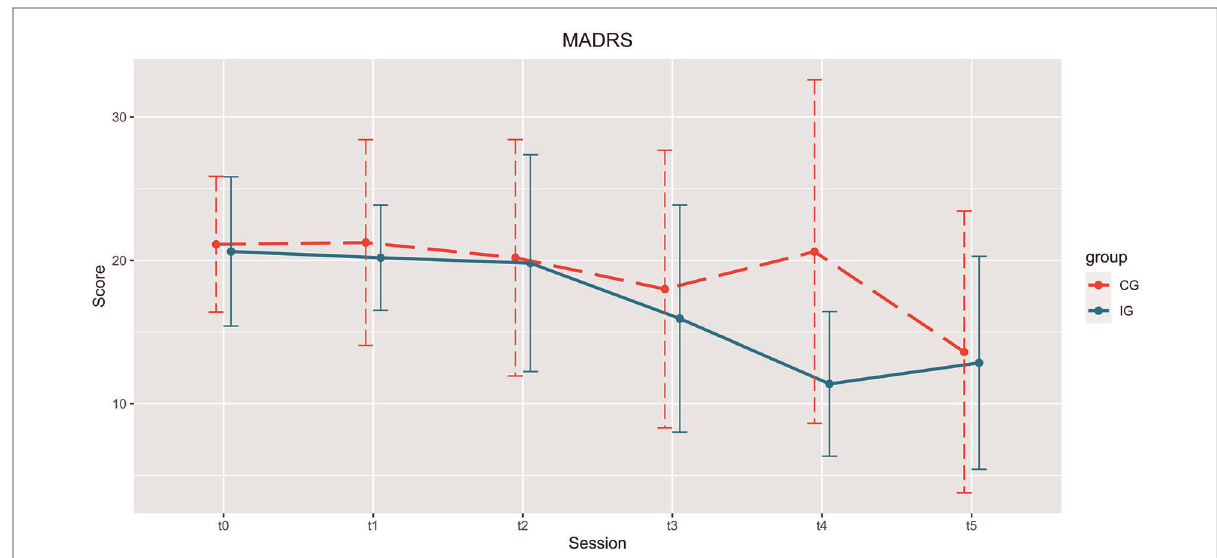
FIGURE 4 Development of the MARDS scores over the course of the study. Depicted are means and standard deviations (SD). Participants of the IG showed signi fi cantly higher improvement in the reduction of depression scores up until 4 weeks after the end of the training